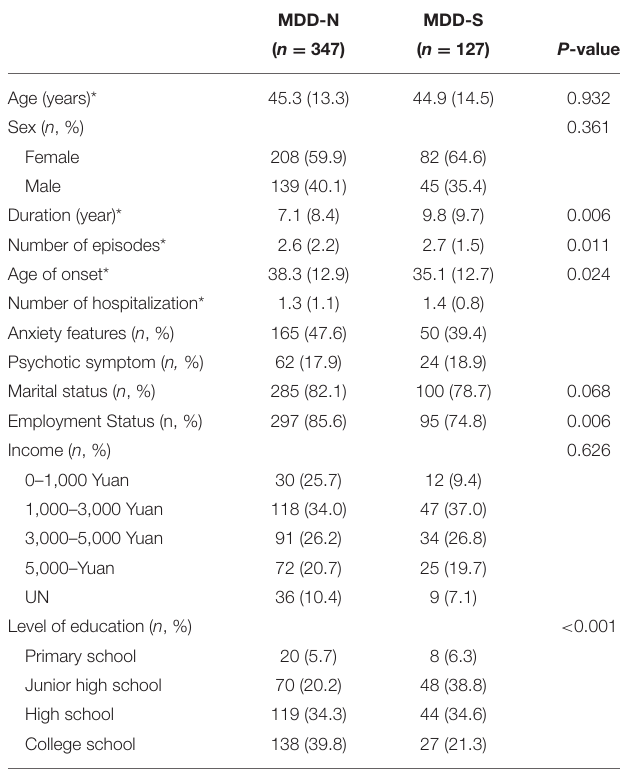
TABLE 1 | Demographic information and clinical